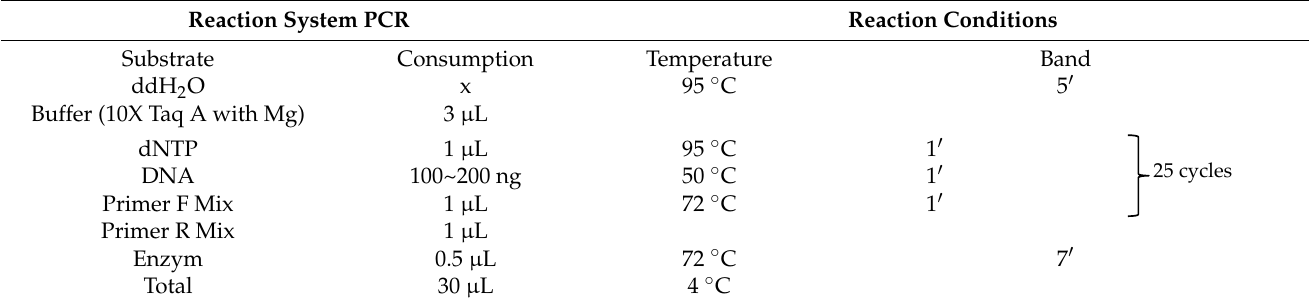
Table 2. PCR reaction system (Kapa DNA polymerase) and reaction conditions. PCR Reaction System